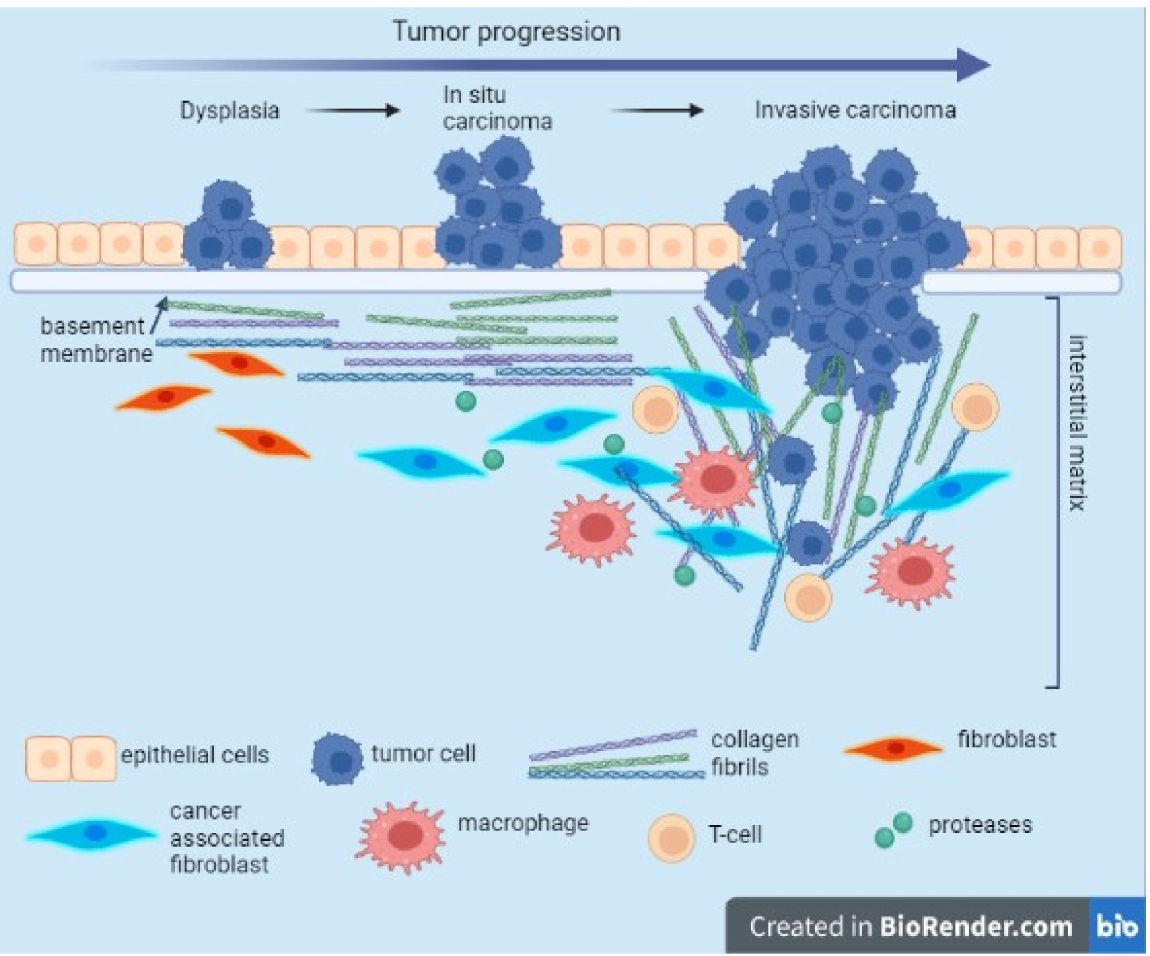
Figure 1. Evolution of collagen fibril organization during tumor progression. During carcinogenesis and cancer development, tumor cells surpass the physical barrier represented by the basement membrane and the interstitial matrix. This event is associated with the enhancement of the activity of the CAFs being able to secrete and reorganize the collagen fibers, increasing the matrix stiffness. Tumor associated macrophages (TAM) and CAFs contribute to collagen remodeling and degradation due to secreted proteases. Modified collagen fibers shift their orientation, allowing migration of invading cancer cells. This image was created with BioRender (https://biorender.com/ (accessed on 30 September